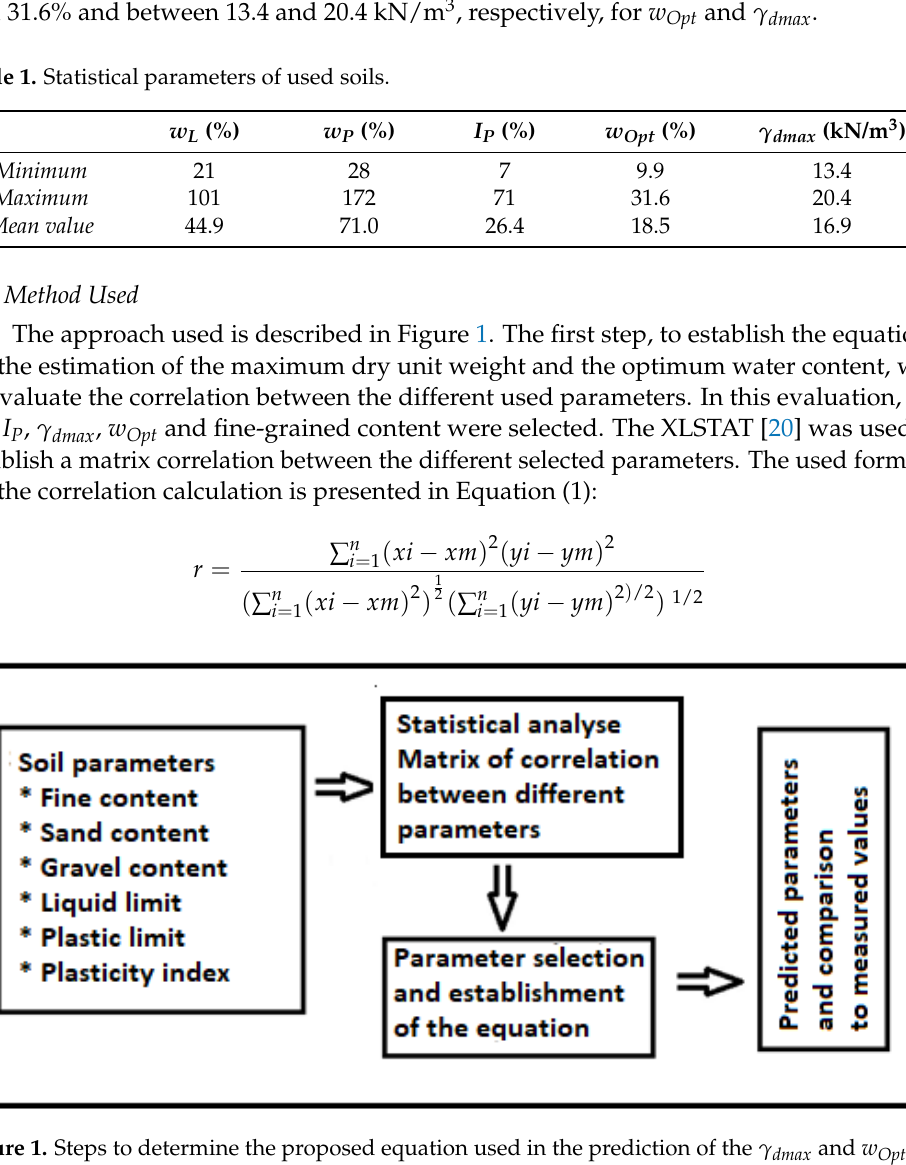
value of the yi variable